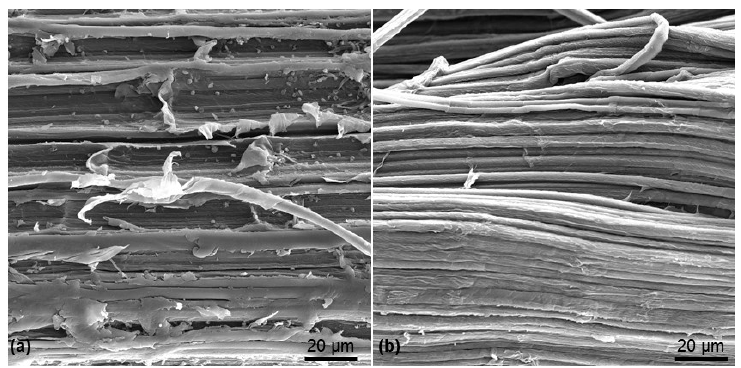
Figure 1. Unbleached CF ( a ) and bleached CF ( b ).